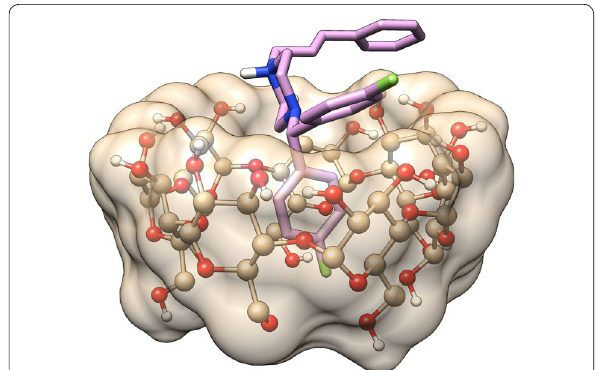
Fig. 3 Computational best molecular docked conformation model of β-CD:FLN inclusion complex performed by Autodoc Vina 1.1.2 [53] showing penetration of F-substituted aromatic ring into β-CD cavity from wider rim side. The docking affinity was obtained to be 5.4 kcal mol − 1 . Also, see Fig. 4 and Additional file 1: Figure S2 for − other docked conformations obtained during docking. β-CD is